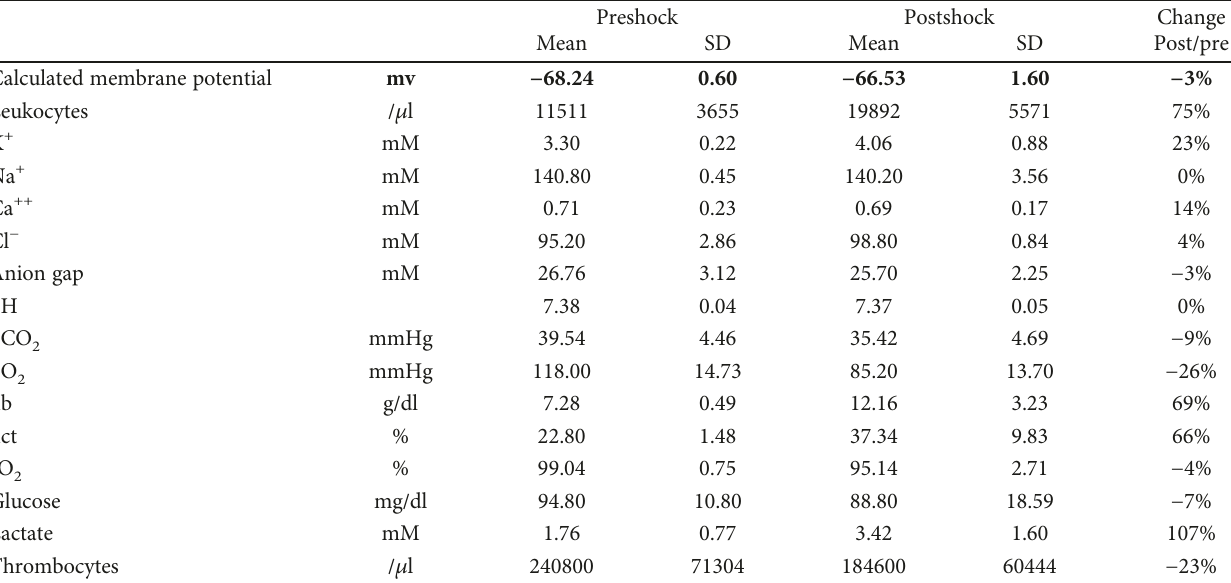
Table 2: Results of blood gas analyses of porcine hemorrhagic shock